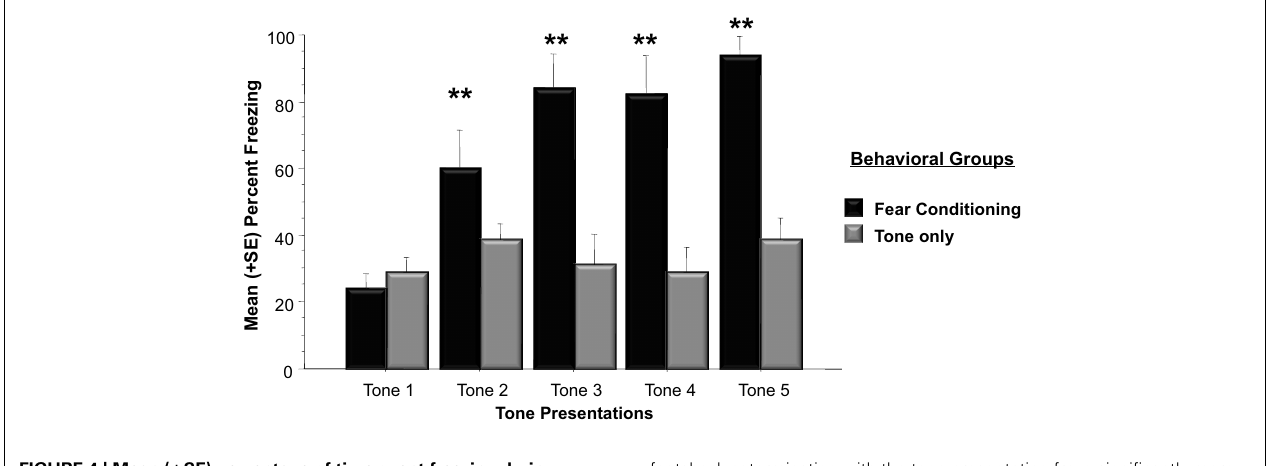
footshock coterminating with the tone presentation froze significantly more during Tones 2–5 (Tone 2: Fear Conditioning vs. Tone Only, p < 0 . 01; Tone 3: Fear Conditioning vs. Tone Only, p < 0 . 01; Tone 4: Fear Conditioning vs. Tone Only, p < 0 . 01; Tone 5: Fear Conditioning vs. Tone Only, p < 0 . 01). ∗∗ p < 0 .